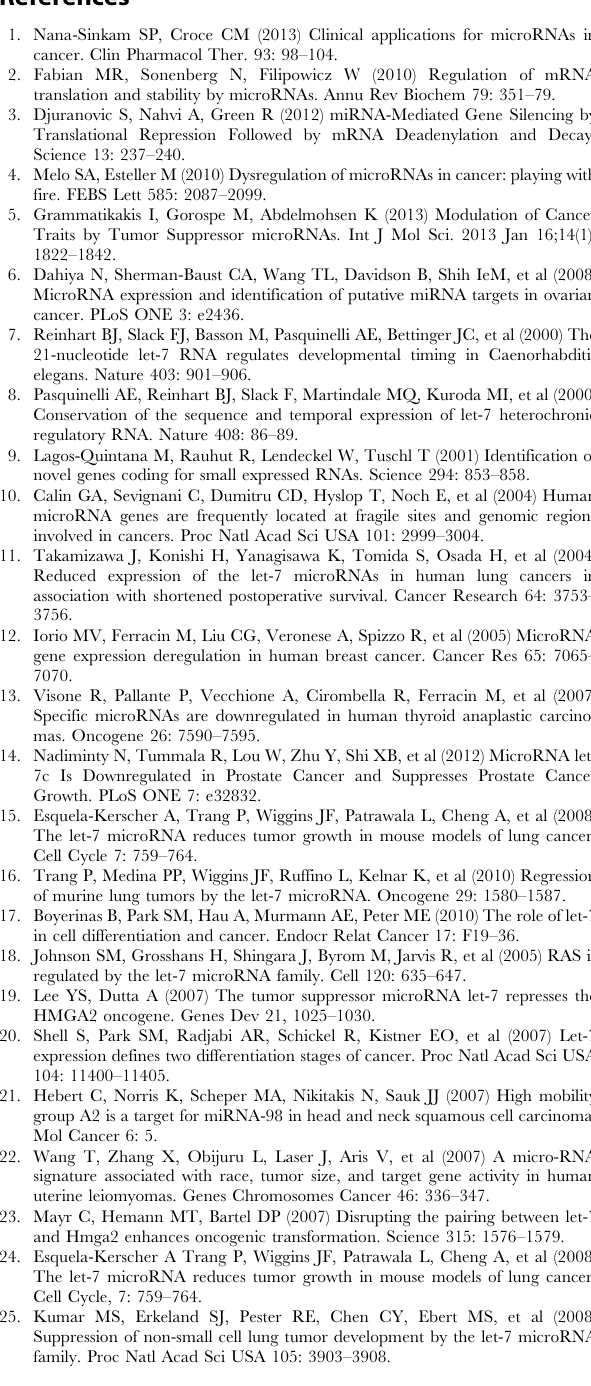
Table S2 Survey of let-7 levels using kinase inhibitor library and psiCHECK2-MKK4. Five hours after transfection of psiCHECK2-MKK4, BG-1 cells were treated with the kinase inhibitor library and luciferase activity (RL/FL) was measured 24 h later. Inhibitor drugs triggering ‘Downregulated reporter activity’ (elevated let-7) were those yielding luciferase activities , 0.6, while drugs triggering ‘Upregulated reporter activity’ yielded luciferase activities . 1.8. All other drugs were classified as having ‘No effect on reporter activity’.